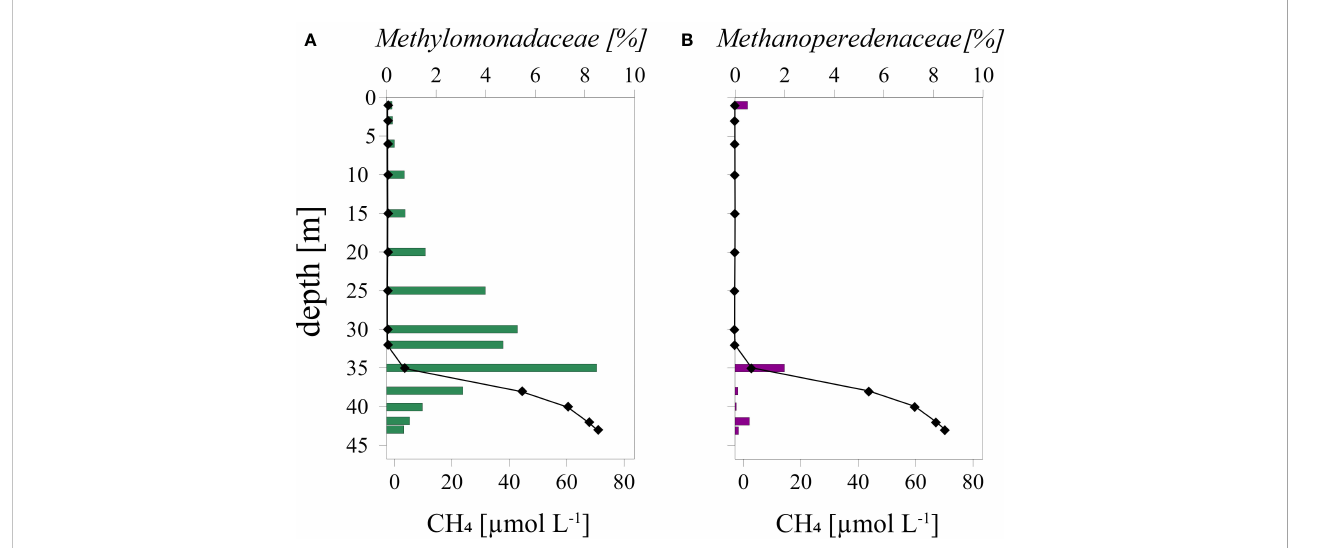
FIGURE 5 Relative abundance of (A) : Methylomonadaceae and (B) : Methanoperedenaceae and CH 4 concentrations in the water column in September 2020 at Scharendijke. The abundance of Methylomonadaceae is relative to the total abundance of all bacteria and the abundance of Methanoperedenaceae is relative to the total abundance of all